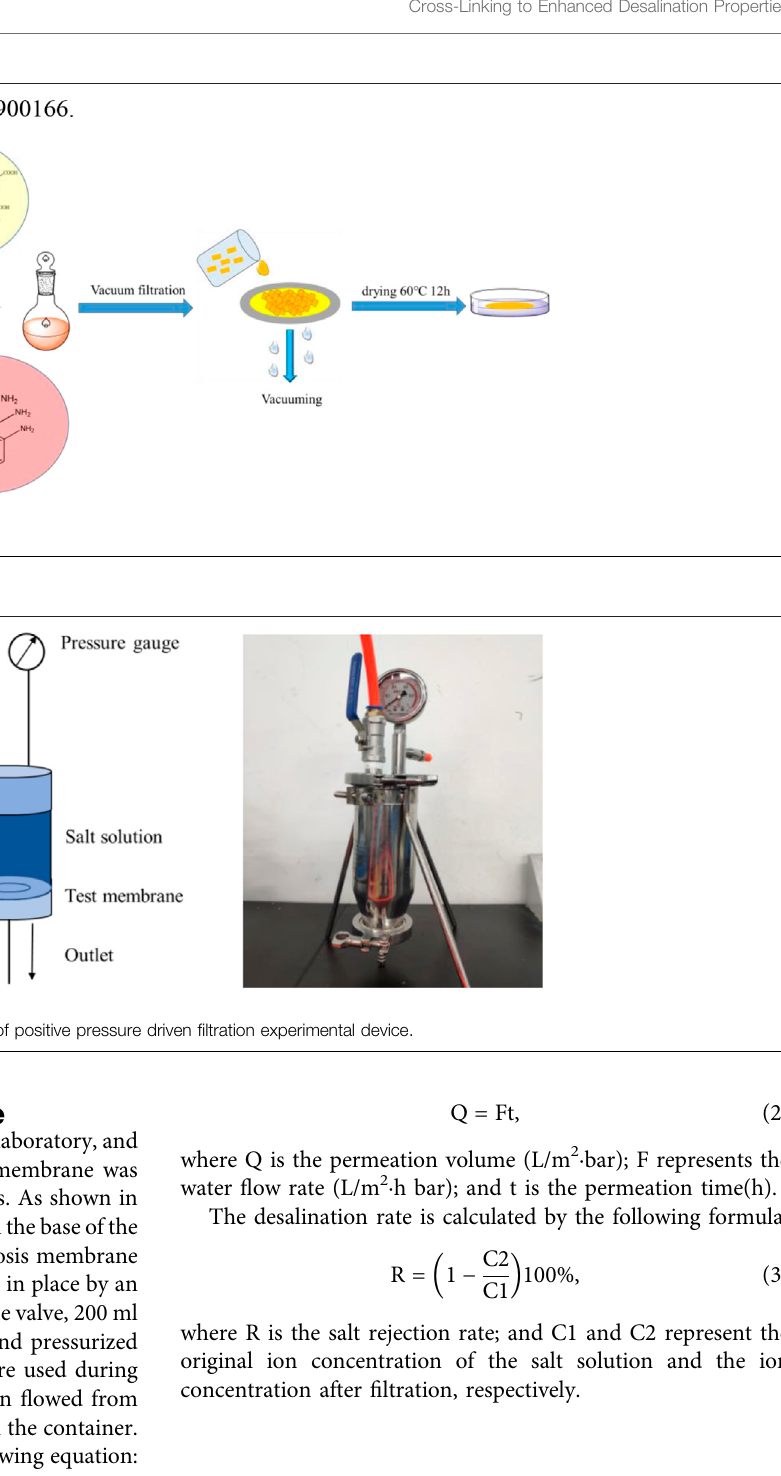
Frontiers in Chemistry |